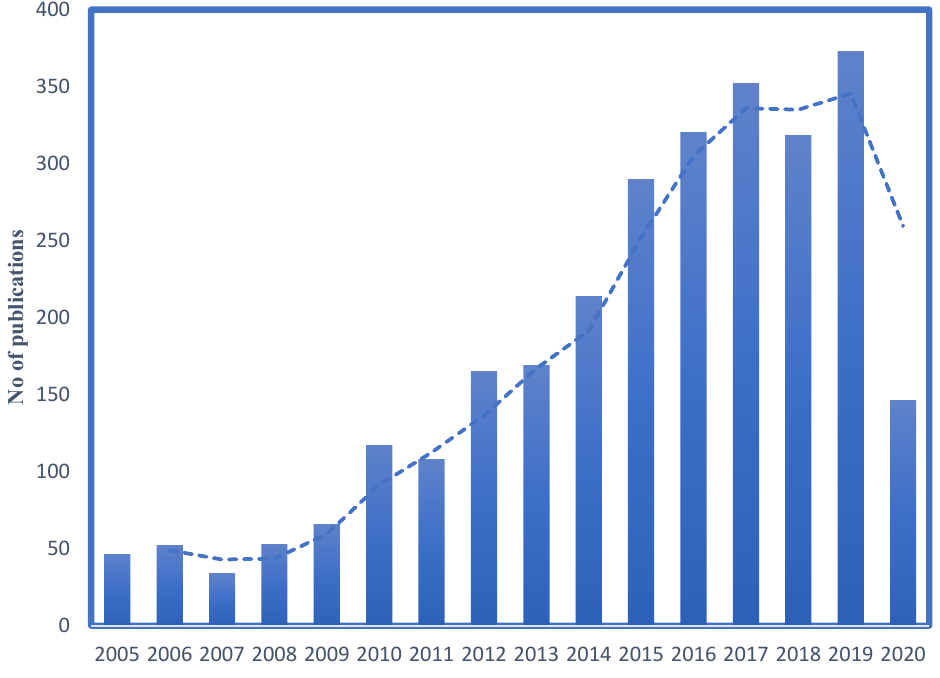
Figure 2. Citation reports of the papers related to the metaheuristics application in CO from 2005–2020 (Web of Science).